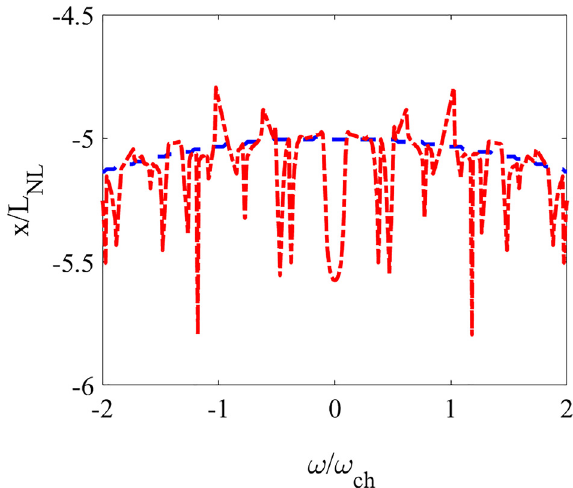
Figure 5: Observation of anomalous phase hopping, and nonzero phase trajectories through different NSPP field excitation: Dashed blue curve is the trajectory of nonzero phase hoppings 𝜙 the plasmonic rogue wave formation, and red dashed-dotted curve is the corresponding phase trajectory for the breather